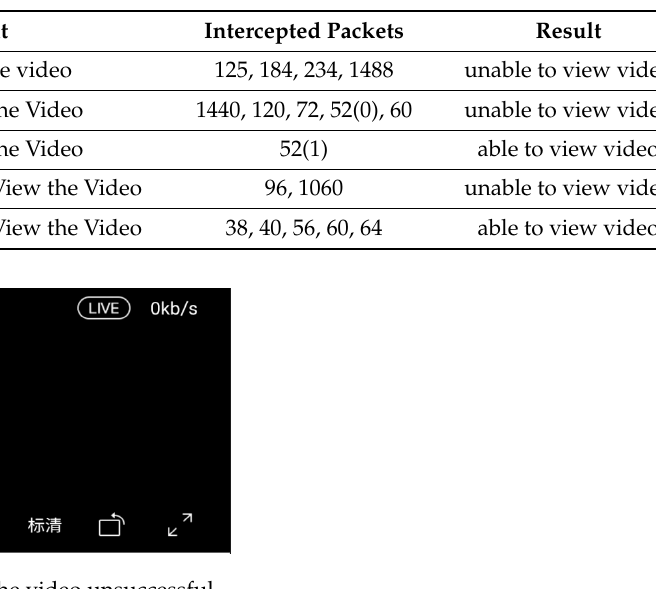
Figure 13. Time consumption comparison. Table 13. Device event control experiment result.